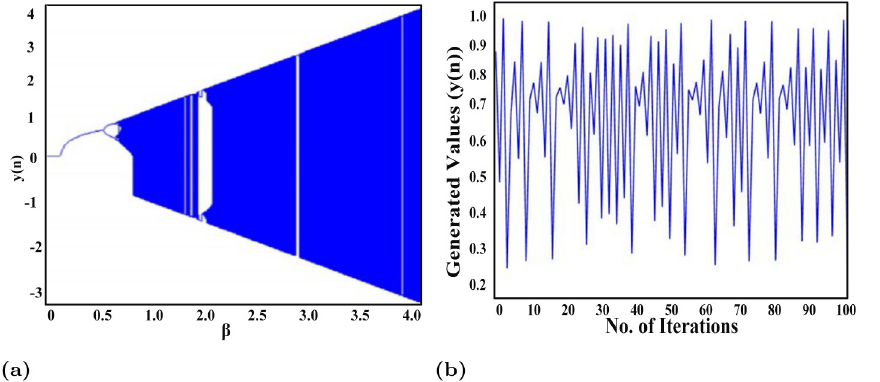
Fig 6. (a) Bifurcation diagram of CSM and (b) Random sequence generated using